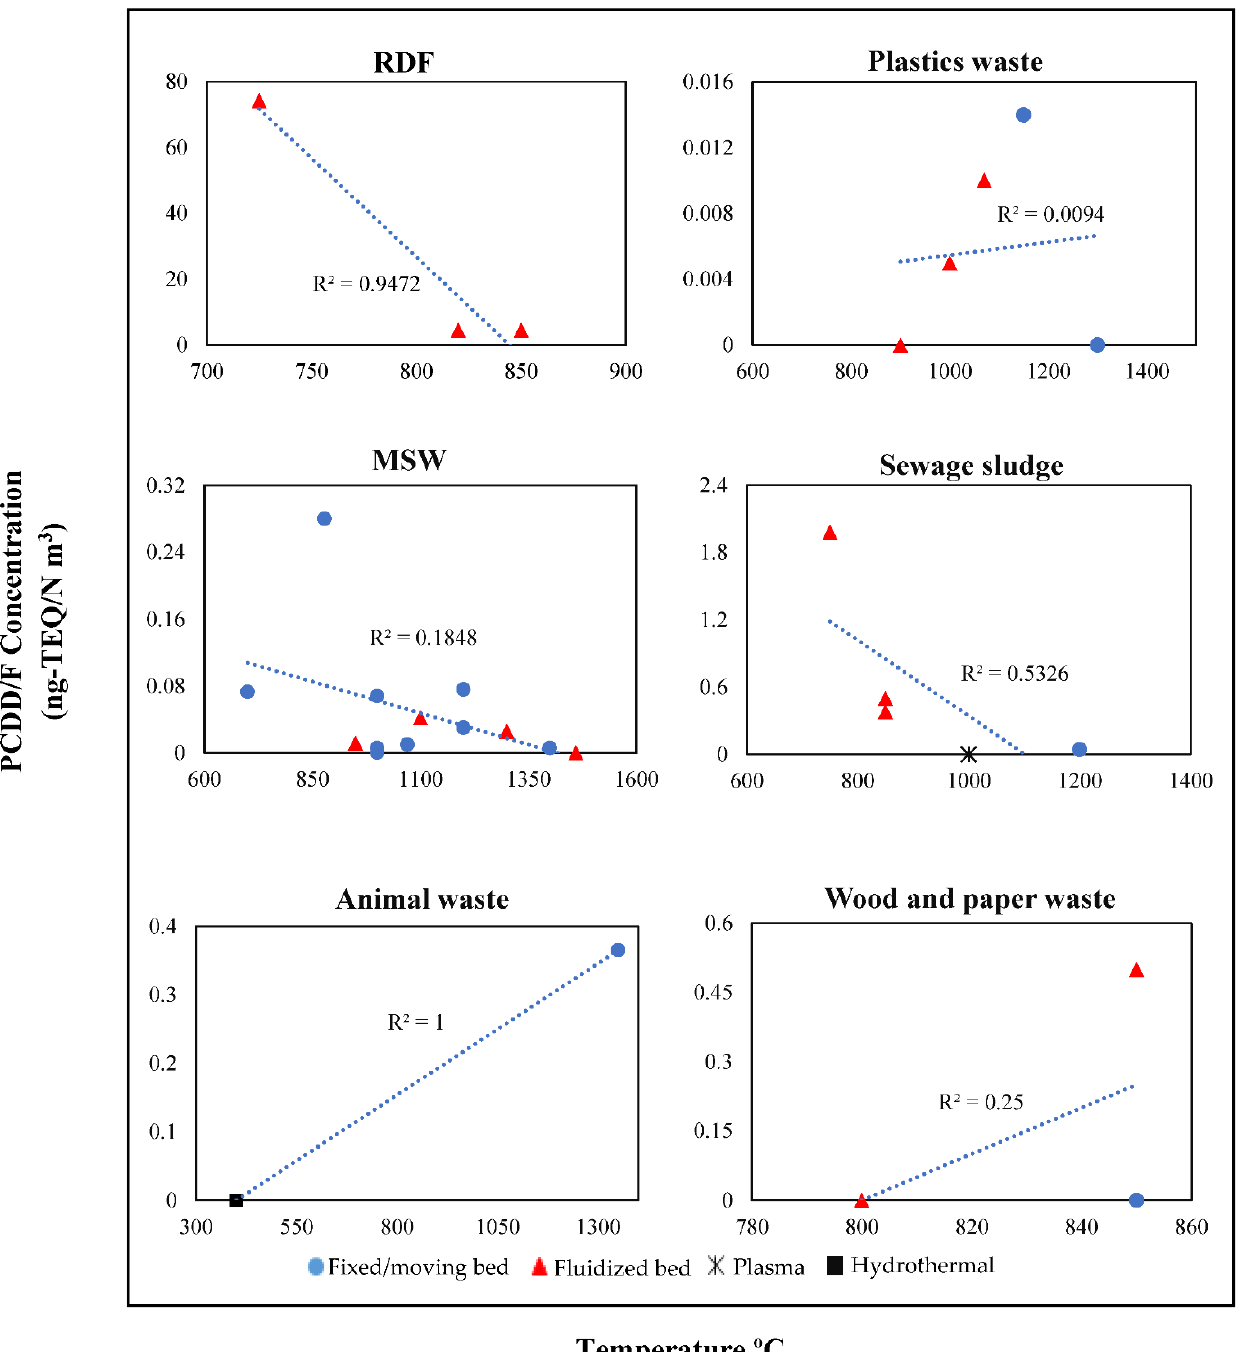
Figure 4. The scatter chart shows the PCDD/Fs concentrations for each feedstock versus temperature. As the number of data points is not enough in the existing literature, it is not possible to say how temperature and PCDD/Fs concentrations correlate for any specific feedstock type, except for MSW, which are the most studied feedstock. Since there is only one study experimenting with textile and hospital waste, they are not included in this figure.